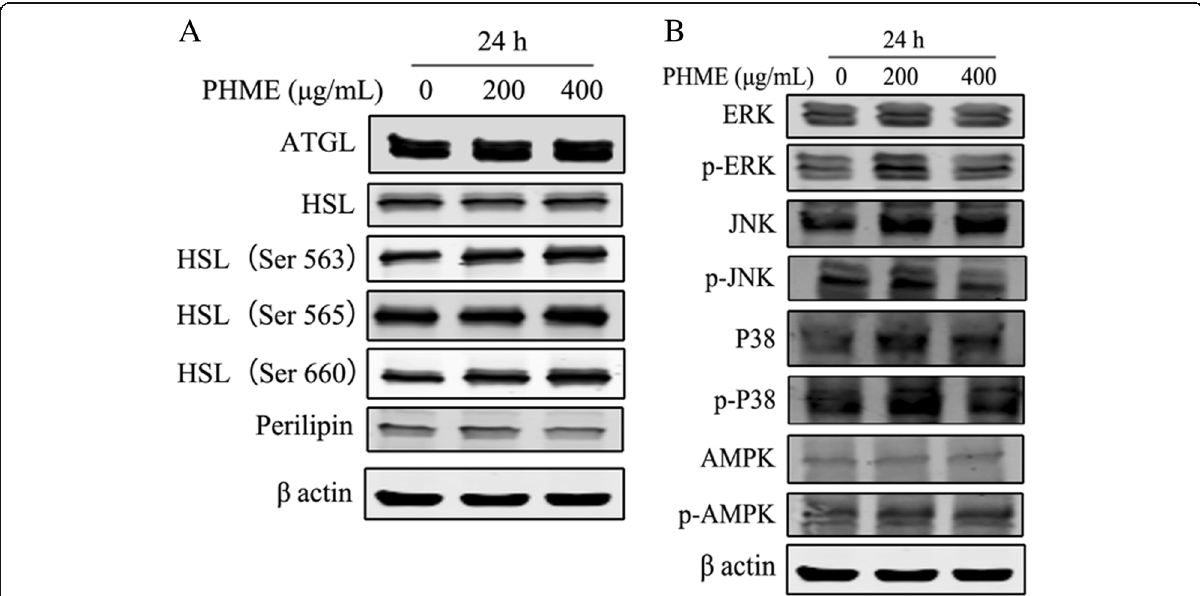
Fig. 3 Effect of PHME on the expression of ATGL, perilipin, HSL and phosphorylated HSL at Ser563, Ser565 and Ser660 ( a ), and on the expression and phosphorylation of ERK, p38, JNK and AMPK ( b ). Fully differentiated 3 T3-L1 adipocytes were treated with 200 and 400 μ g/mL PHME for 24 h, then expression of ATGL and perilipin, as well as basal and phosphorylated levels of HSL, AMPK and MAPKs were measured using western blotting analysis